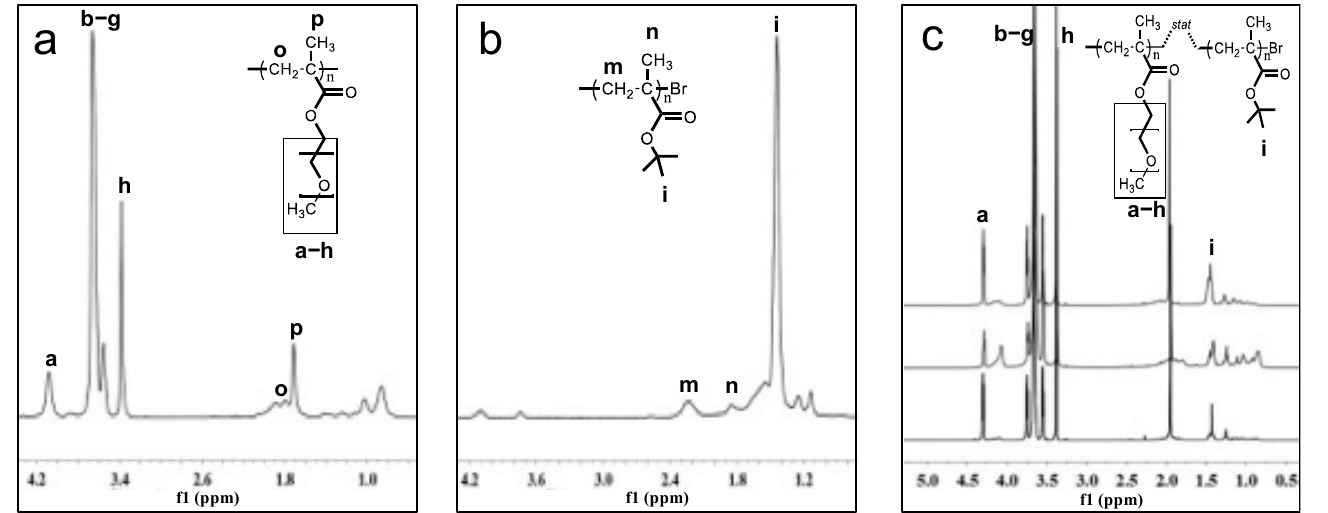
Figure 3. 1 H NMR spectrum of POEGMA ( a ), PtBA ( b ), P(OEGMA 30 - stat -tBA 70 ), P(OEGMA 50 - stat - tBA 50 ) and P(OEGMA 70 - stat -tBA 30 ) (( c ), from top to bottom).